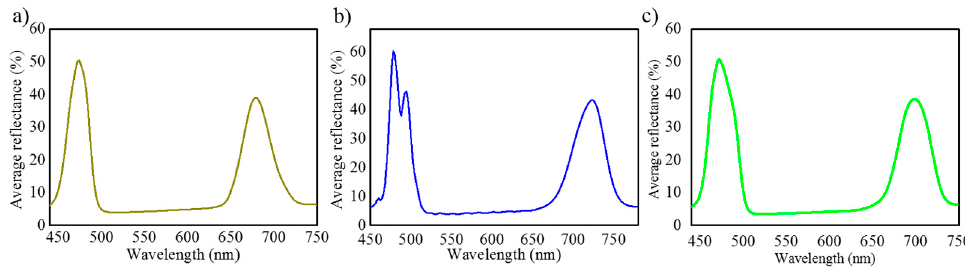
Figure 7. UV-Visible Spectra of NAA-GIFs with varying number of periods, i.e., ( a ) N = 150, ( b ) N = 200, ( c ) N = 250.